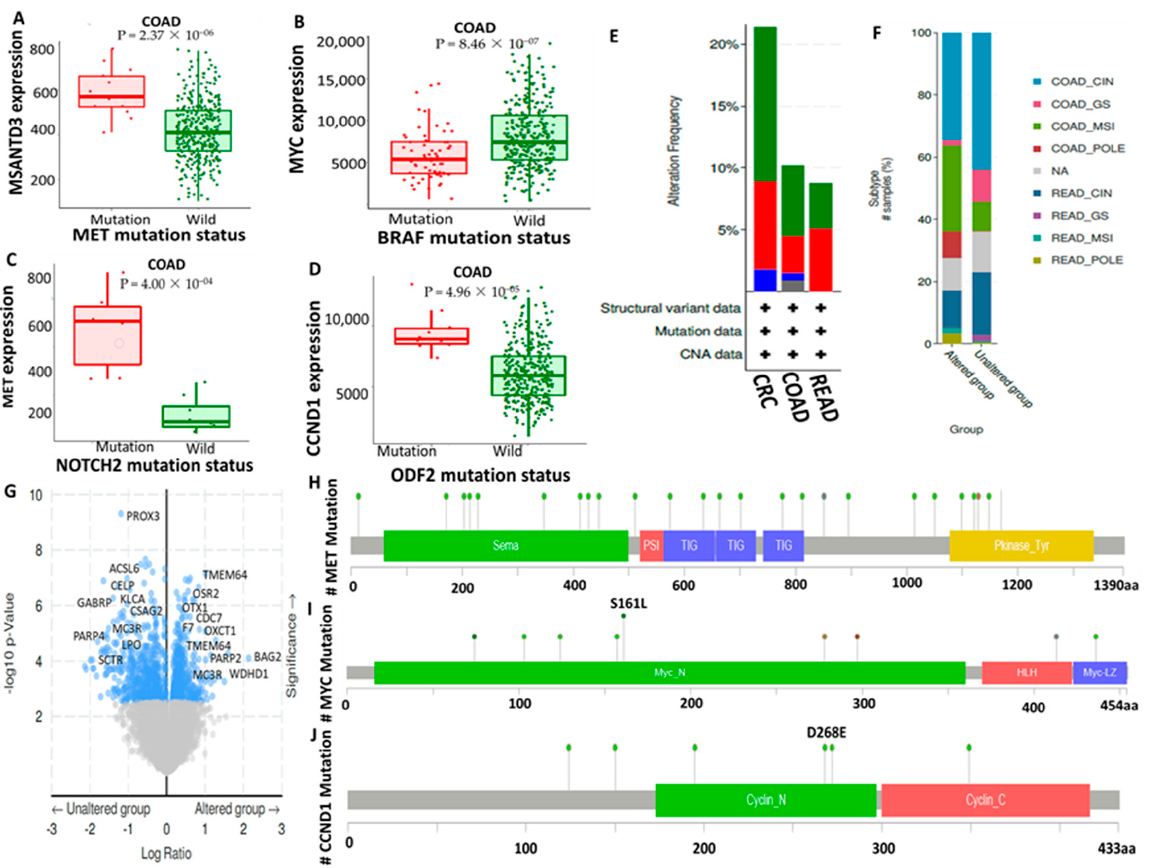
Figure 6. Genomic alterations in c-Met/MYC/cyclin D1 (CCND1) signatures are associated with poor prognoses of colorectal cancer (CRC) cohorts. ( A ) Mutation of the c-Met gene was asso- ciated with high expression levels of MSANTD3. ( B – D ) Changes in expression levels of the c- Met/GSK3 β /MYC/CCND1 oncogenes were linked to mutations of the BRAF, NOTCH2, and ODF2 genes at the target level, compared to the wild-type (WT) group. ( E ) Bar graph showing higher alter- ation frequencies of c-Met/GSK3 β /MYC/CCND1 gene signatures in CRC, compared to colorectal adenoma (COAD) and rectal adenocarcinoma (READ). ( F ) Bar graph showing alterations of the c- Met/GSK3 β /MYC/CCND1 genes according to sample subtypes. ( G ) Volcano plot showing unaltered and altered genes associated with c-Met/GSK3 β /MYC/CCND1 signatures with − log10( p values) set as a standard. ( H – J ) A lollipop diagram showing the distribution of c-Met/GSK3 β /MYC/CCND1 mutations in CRC across protein domains. Mutations are color-coded as missense, truncating, and in-frame